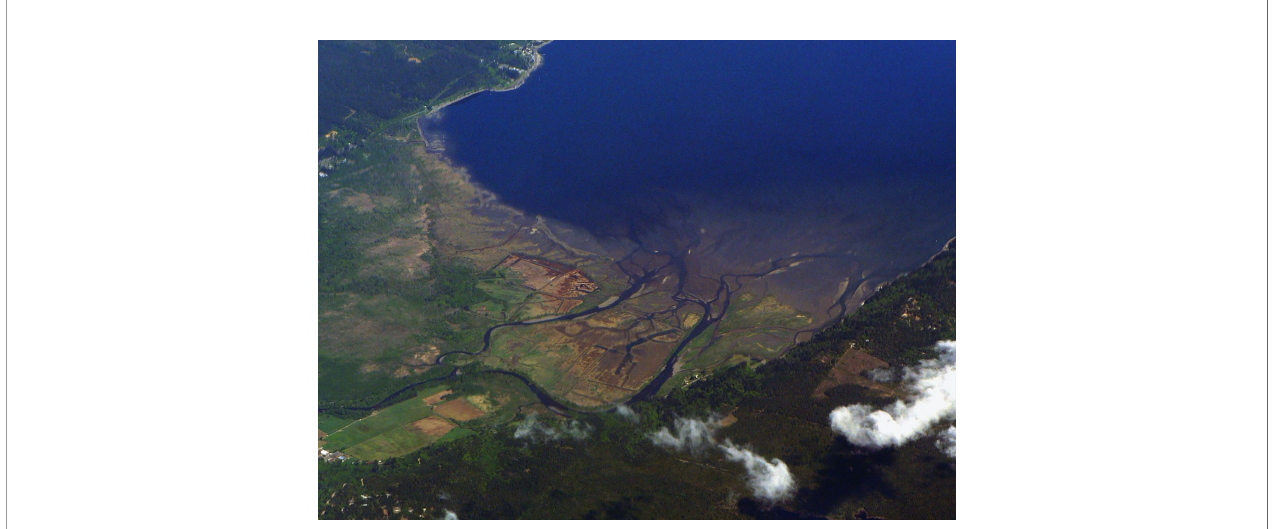
FIGURE 6 | Skokomish River Branches Join to Form a Delta on Hood